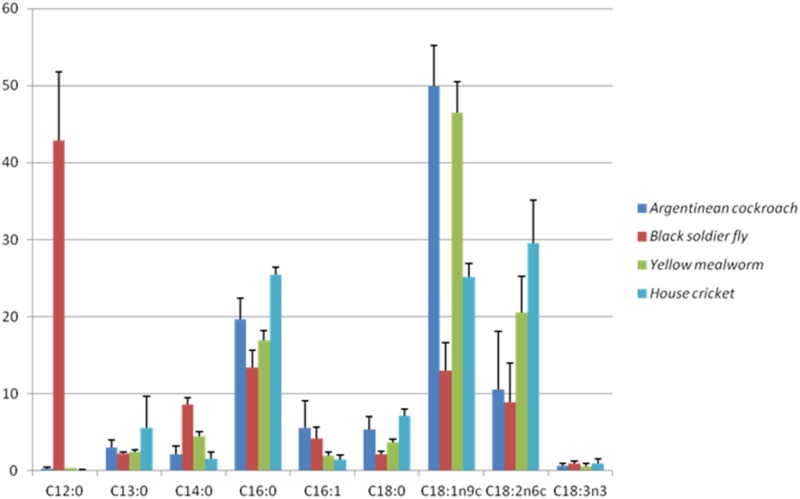
Average fatty acid composition of Argentinean cockroach, Black soldier fly, Yellow mealworm and House cricket reared on four experimental diets and their respective control diets.